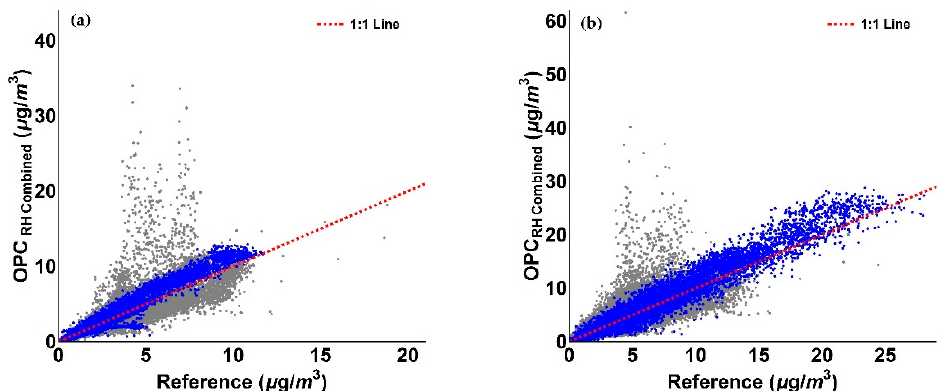
Figure 15. Figures illustrating the comparison of RH corrected PM measurements assuming Ammonium Sulphate (grey points) and Sodium Chloride (blue points) as unique chemical species for PM for the periods discussed above. ( a ) PM 1 ; ( b ) PM 2.5 .